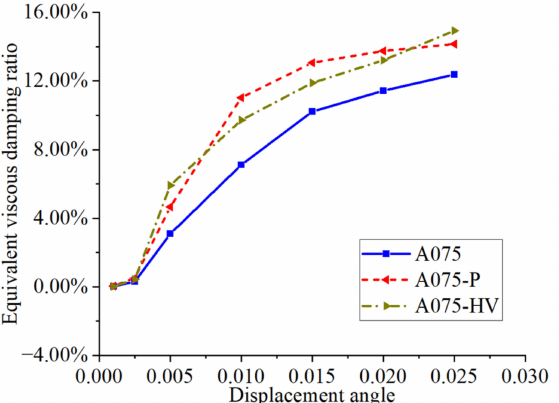
Figure 19. Equivalent viscous damping ratio of different